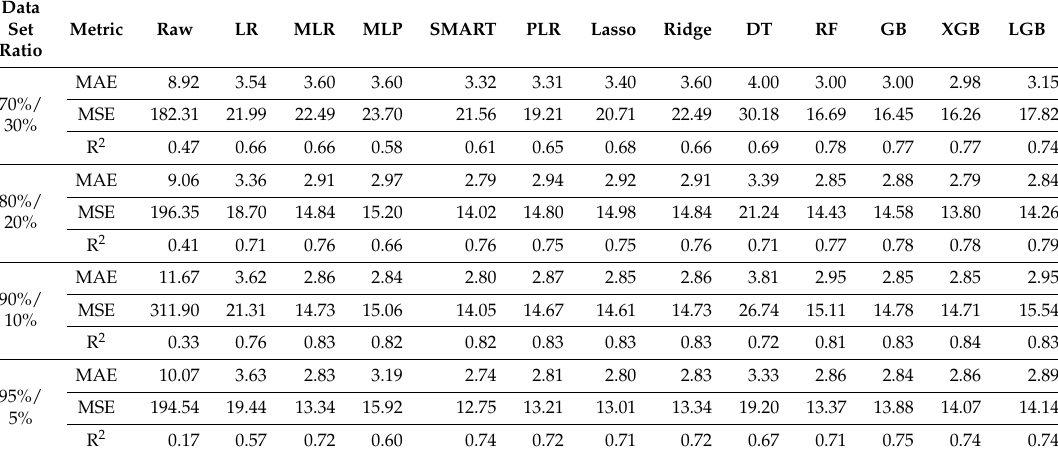
Table 8. Metric analysis of various calibration methods (sequential method, 5 min sampling interval condition).